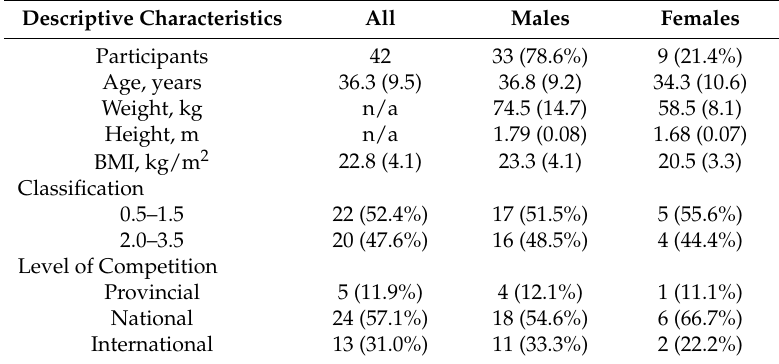
Table 1. Descriptive Characteristics.